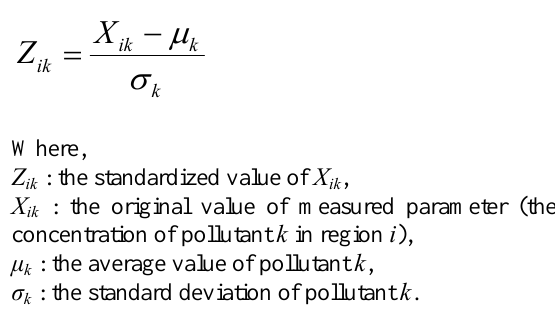
Figure 1: Map of 22 cities (counties) in